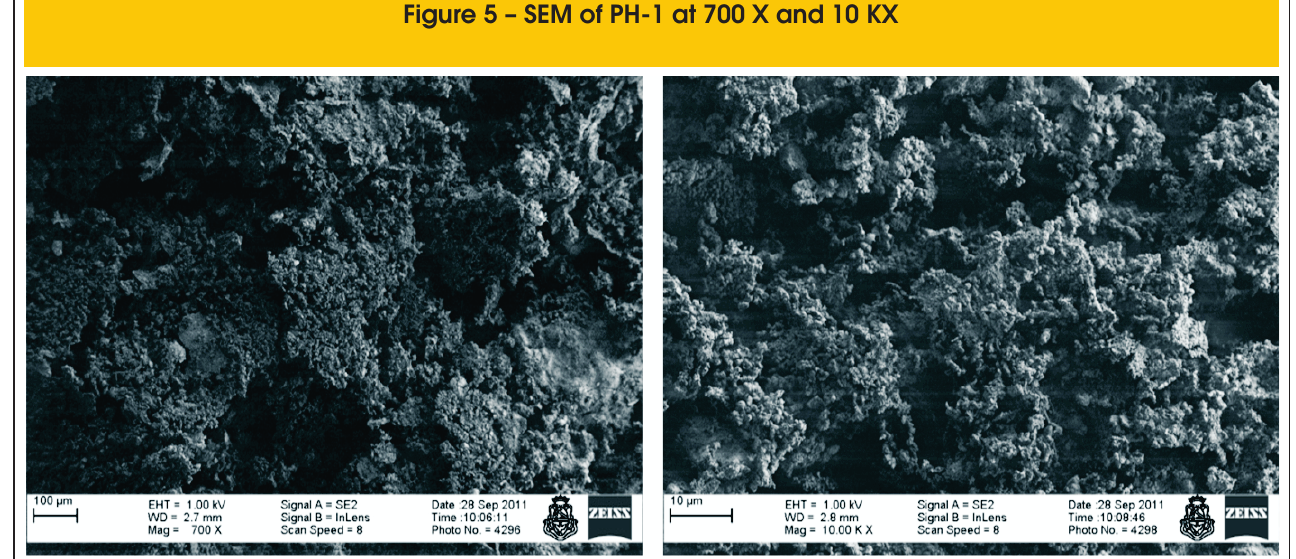
Figure 5 – SEM of PH-1 at 700 X and 10